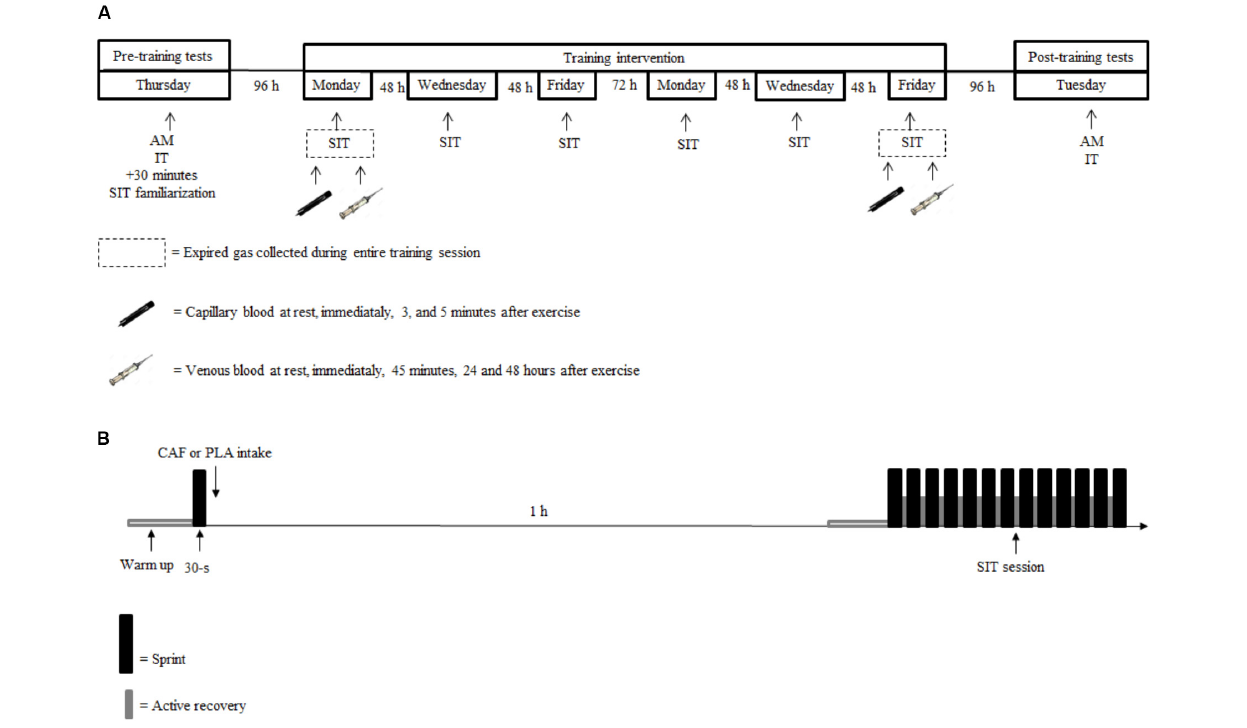
FIGURE 1 | Experimental design of the study (A) , sprint interval training (SIT) session (B) . AM, anthropometric measurements; IT, incremental test; SIT, sprint interval training session; 30-s, baseline 30-s all-out